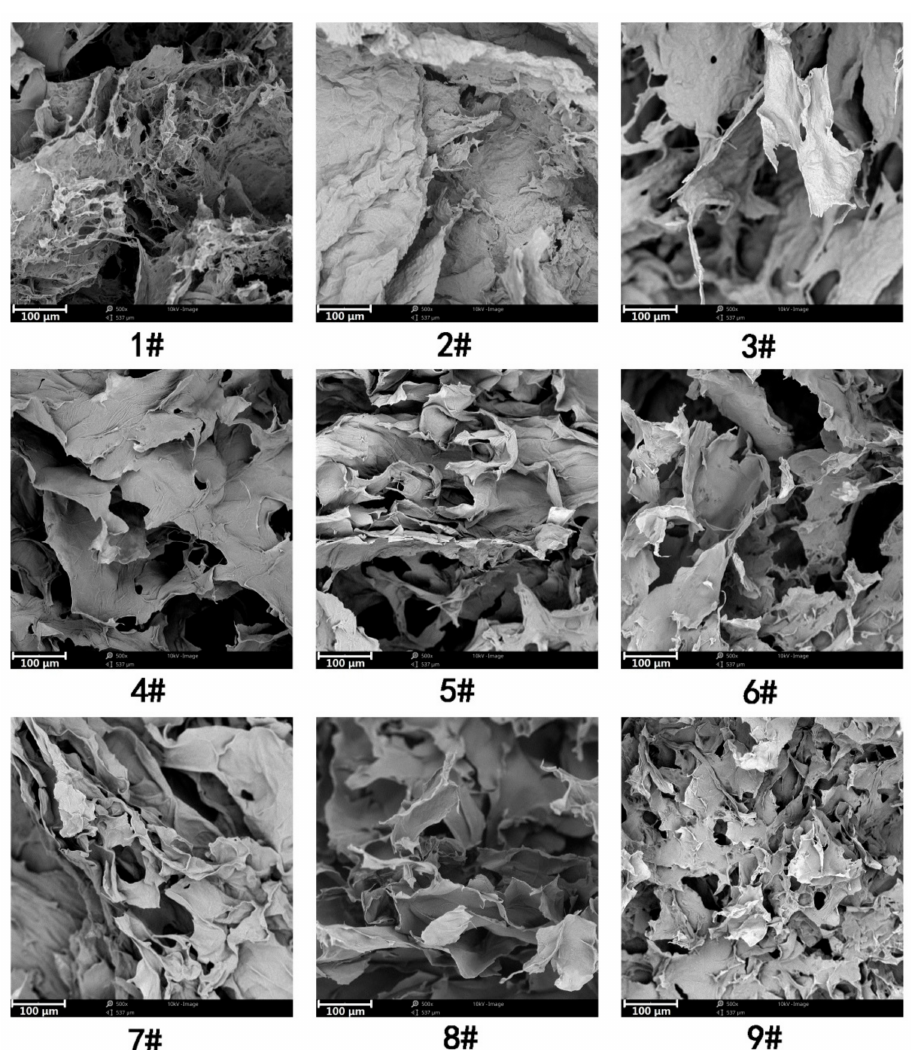
Figure 6. SEM micrographs of the freeze-dried CNFs hydrogels corresponding to those in the experiment of Table